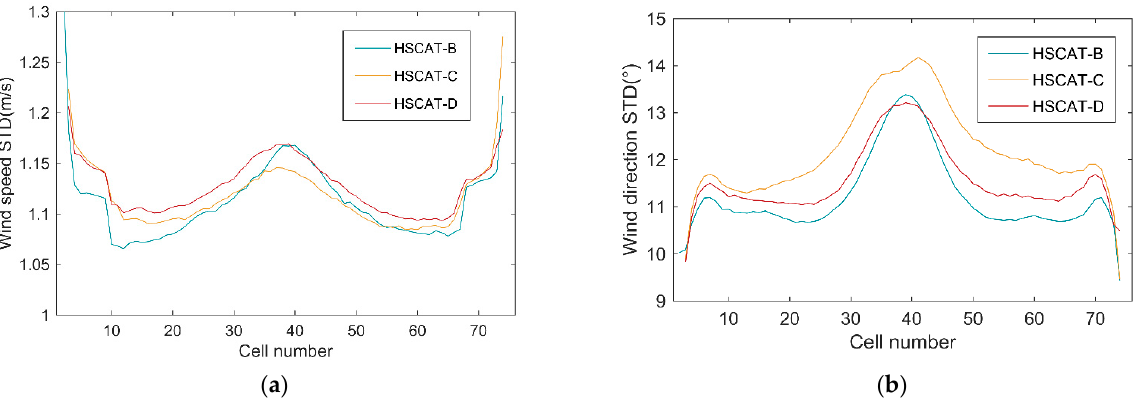
Figure 7. Cross-track variations in comparisons between scatterometer winds and ECMWF winds: ( a ) STD of wind speed differences, and ( b ) STD of wind direction differences.